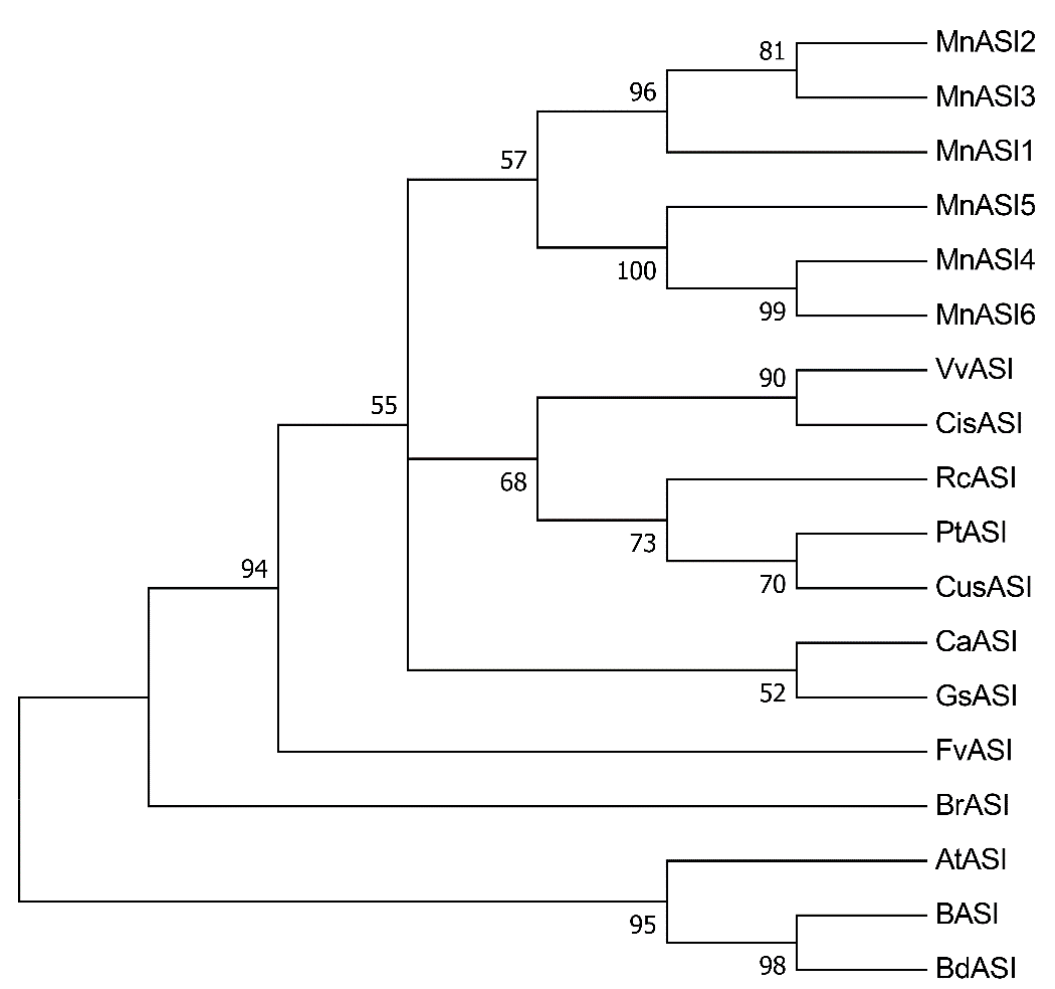
Figure 2. Phylogenetic tree of ASI amino acid sequences in mulberry and other plants. The tree is constructed using the neighbor-joining method. The bootstrap value is expressed as a percentage.